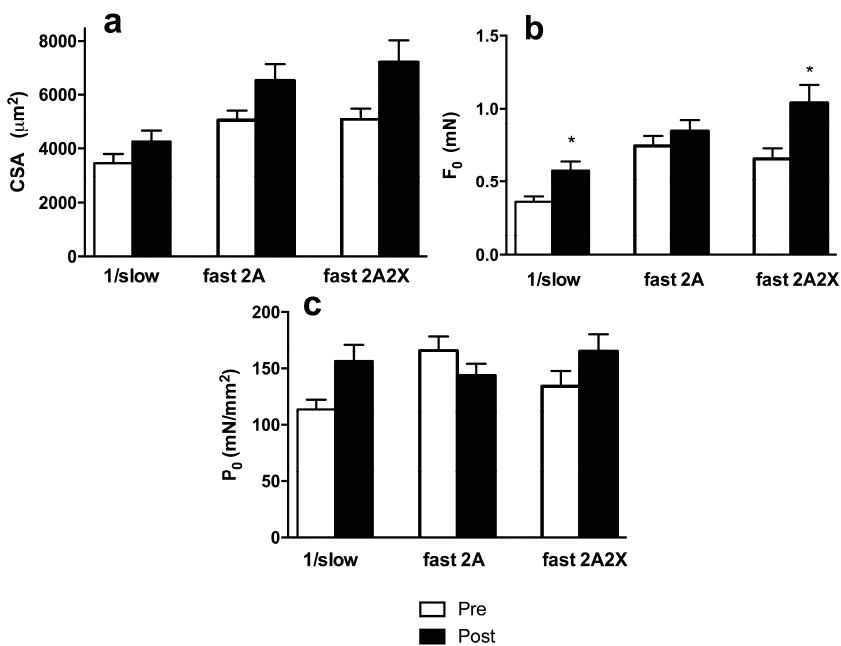
Figure 5. Response of individual fiber types, classified on the basis of their MyHC isoform composition, to RT training. Fibers from NP and HP subjects are pooled together. Means and Standard Errors. Significant difference between post ‐ and pre ‐ training: * p < 0.05.